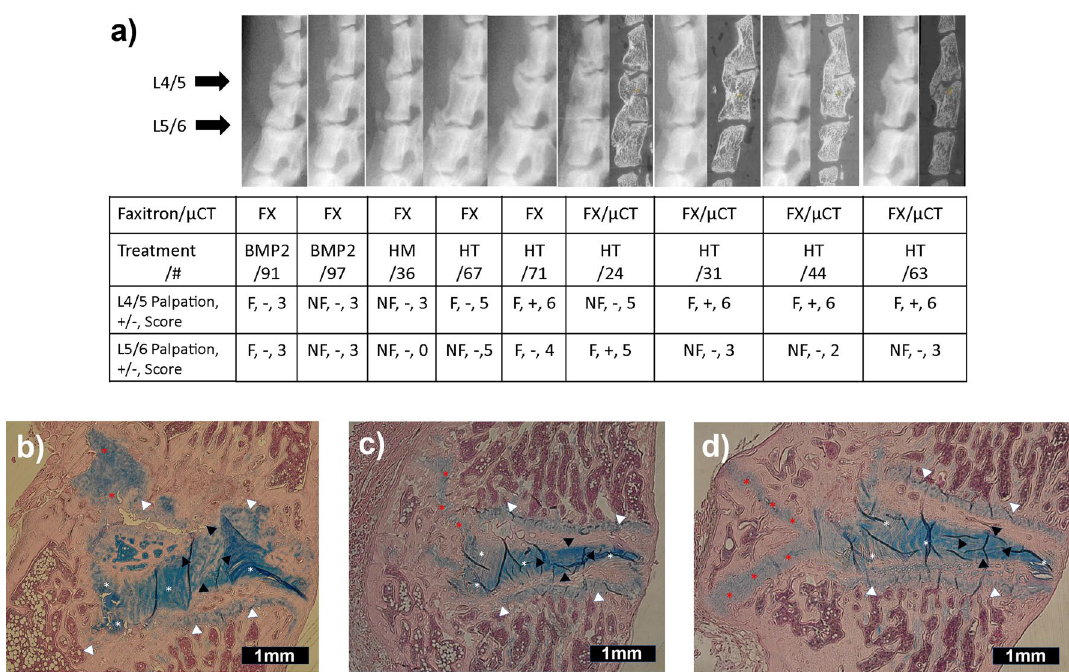
Figure 4. Fusion status assigned by palpation, radiography (faxitron or micro-CT) and histology don’t always directly translate at 12 weeks after disc-implantation of BMP-expressing cells. ( A ) Lateral faxitron and midsagittal micro-CT images (when available) for several specimens where palpation (“Palpation” – fused (F) / not fused (NF)) was inconsistent or non-correlative to dichotomous radiographic [fused (+)/not fused (−)] or the 0–6 sum score (sum shown, 0–4 is not fused and 5–6 is fused). BMP treatment and specimen number are indicated to allow cross-comparison with Figs. 3, 4B–D, and Supplementary Fig. S1. Note that segmental kyphosis or disc height loss of an L4/5 or L5/6 segment tends to correlate with anterior fusion mass status (compare levels fused/not for specimens 24, 31, 44, and 63). ( B )–( D ) Alcian blue stained histology sections triangle), anterior and posterior AF lamellae (white asterisks), nucleus pulposus (NP) (black triangle), and presence of cartilage clefts (red asterisks). Images are of the L4/5 level of each specimen, ( B ) shows